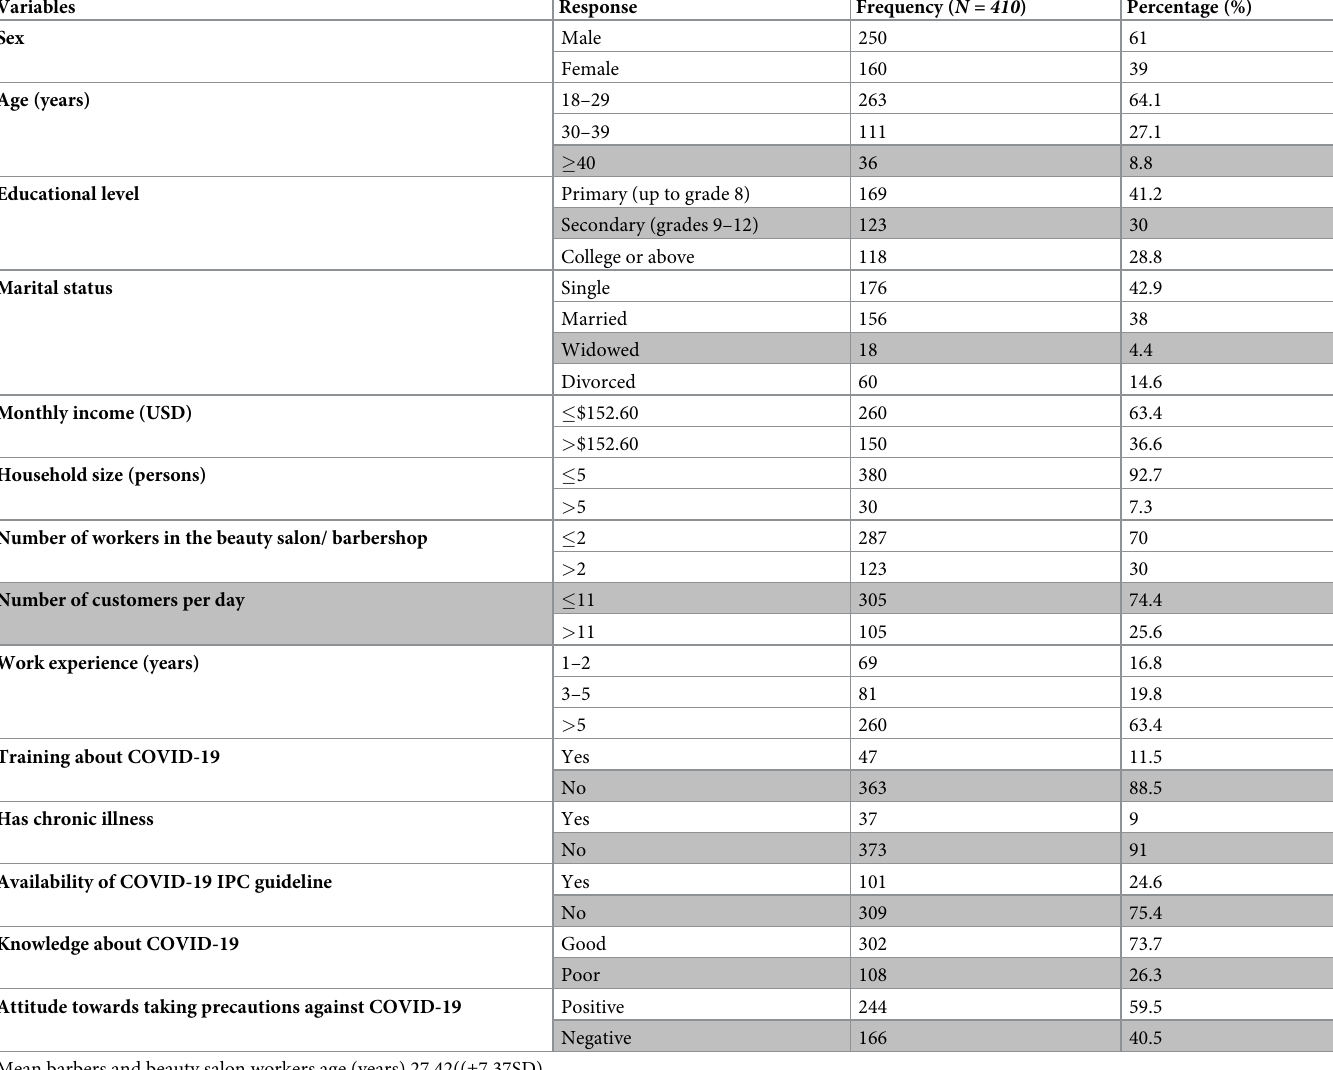
Table 1. Socio-demographic and economic characteristics of barbers and beauty salon workers in Dessie City and Kombolcha Town, Northeastern Ethiopia, Janu- ary 5 to February 10,